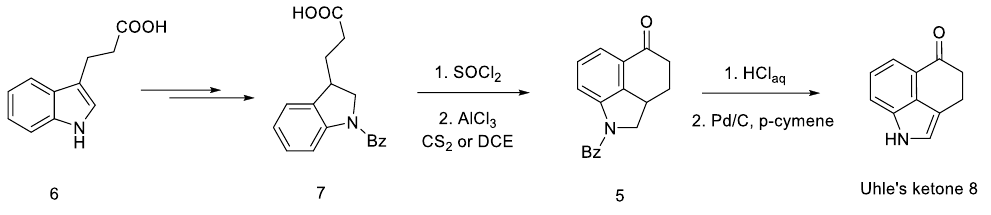
Figure 9. Indole scaffold (red) in the lysergic acid molecule.